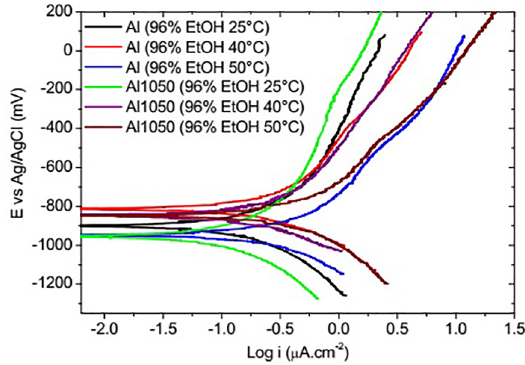
Figure 3. Potentiodynamic polarization curves for commercial grade aluminum (Al) and Al 1050 alloy in 96% ethanol at 25°C, 40°C and